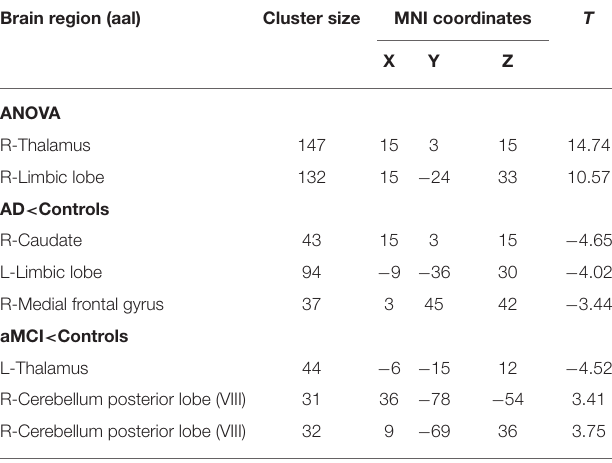
TABLE 2 | Regions showing resting state functional connectivity (rs-FC) changes in cerebellum left crus II. Brain region (aal) Cluster